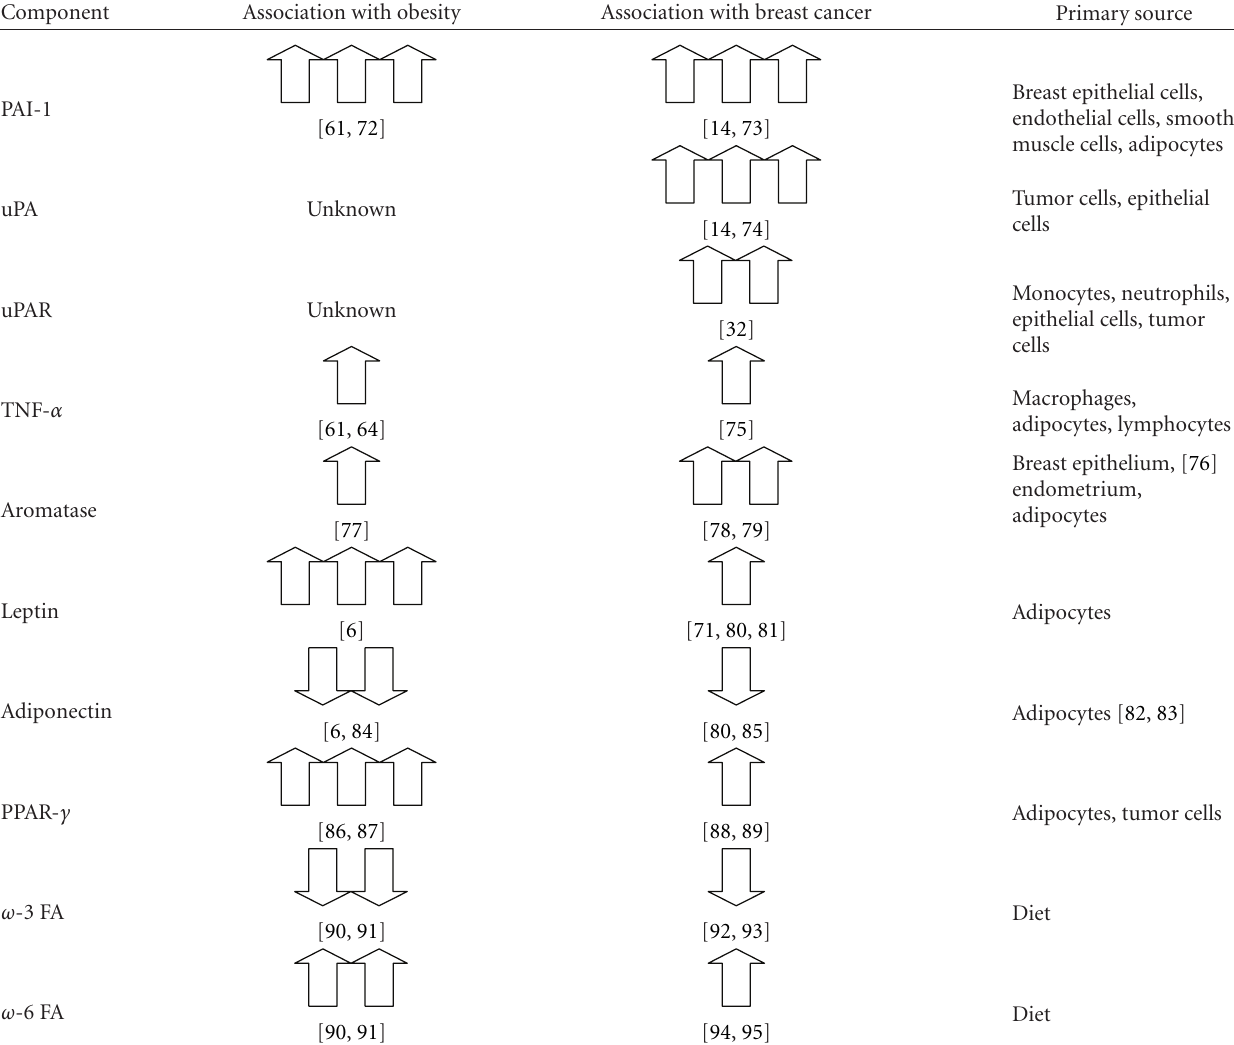
Table 1: Relationship between obesity, PPAR- γ , fatty acids, and increased risk of breast